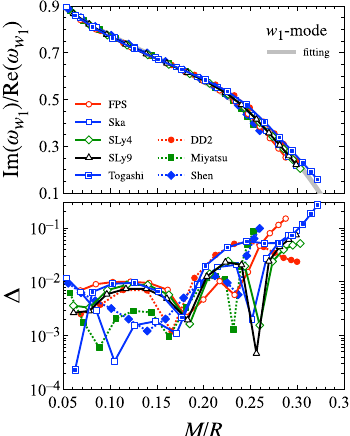
Fig. 4 The ratio of Im (ω) to Re (ω) of the w 1 -mode for various EOSs is shown as a function of the corresponding stellar compactness (top panel), where the solid line denotes the fitting line given by Eq. (4). The bottom panel denotes the relative deviation of the estimation with the fitting formula from the values of Im (ω) /Re (ω) calculated via the eigenvalue